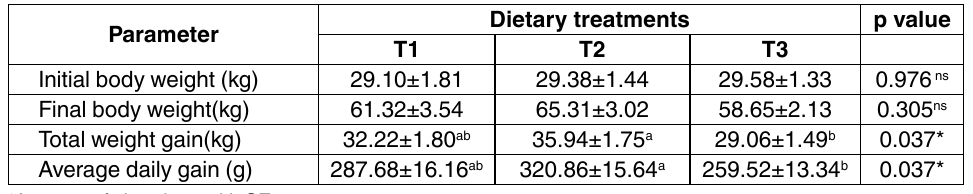
table 3. Fortnightly average body weight and average daily gain 1 of the calves maintained on the three experimental rations, kg